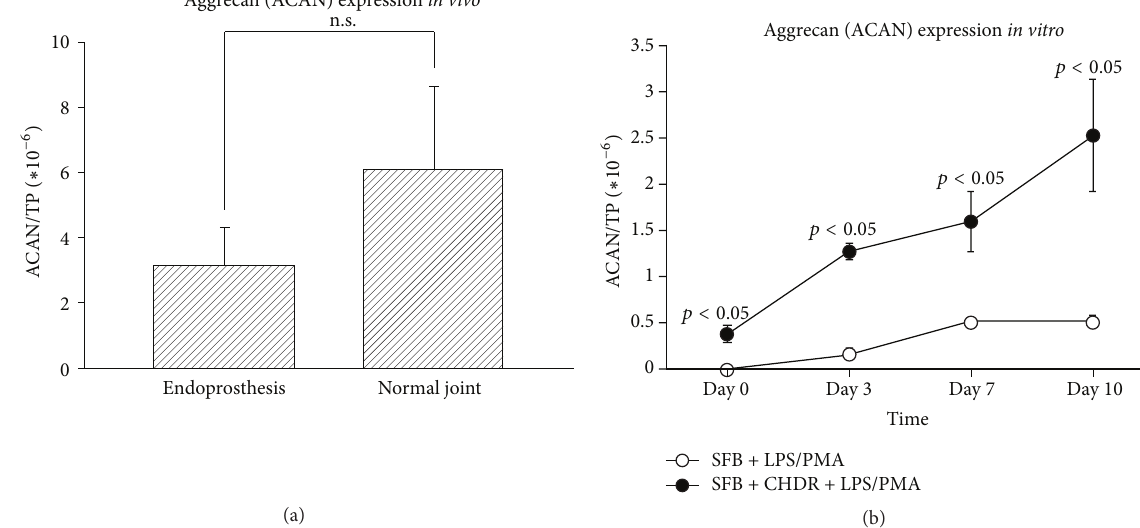
Figure 2: (a) shows that synovial aggrecan levels were reduced in patients with an endoprosthetic implant (no cartilage) compared to those with normal joints (with cartilage). This difference failed to attain statistical significance. (b) demonstrates the in vitro model’s corresponding data. Similarly, aggrecan concentrations were statistically significantly higher in the setting with chondrocytes.